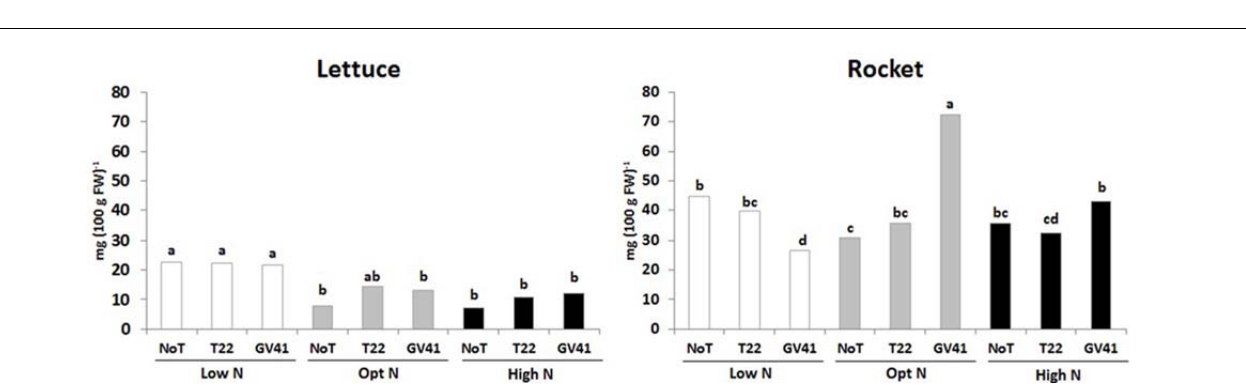
FIGURE 1 | Total, marketable and non-marketable yield of lettuce and rocket as affected by N fertilization doses and Trichoderma inoculation. Low N, non-fertilized conditions (low N availability) for both crops; Opt N, optimal N fertilization, amounting to 90 kg N ha − 1 and 60 kg N ha − 1 for lettuce and rocket, respectively; High N, supraoptimal N fertilization, amounting to 180 and 120 kg N ha − 1 for lettuce and rocket, respectively; NoT, non-inoculated control; T22, T. harzianum strain T22; GV41, T. virens strain GV41. Different letters indicate different means according to LSD test ( P < 0.05). Lower cases are referred to the marketable weight, while upper cases are referred to the total weight production.